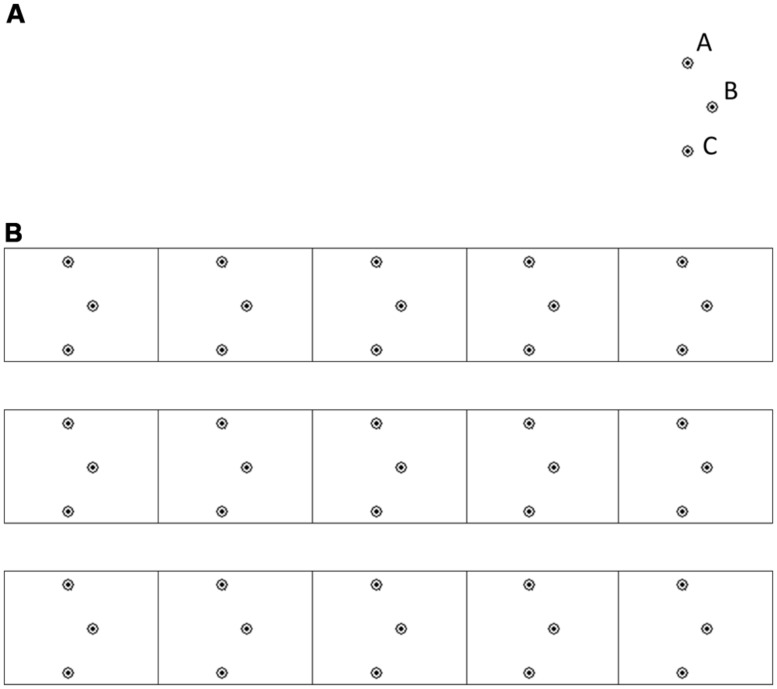
The “invented letter” stimuli. (A) A single stimulus. Writing direction A-B-C. (B) A block of the invented letter task. The writing direction is from right-to-left.